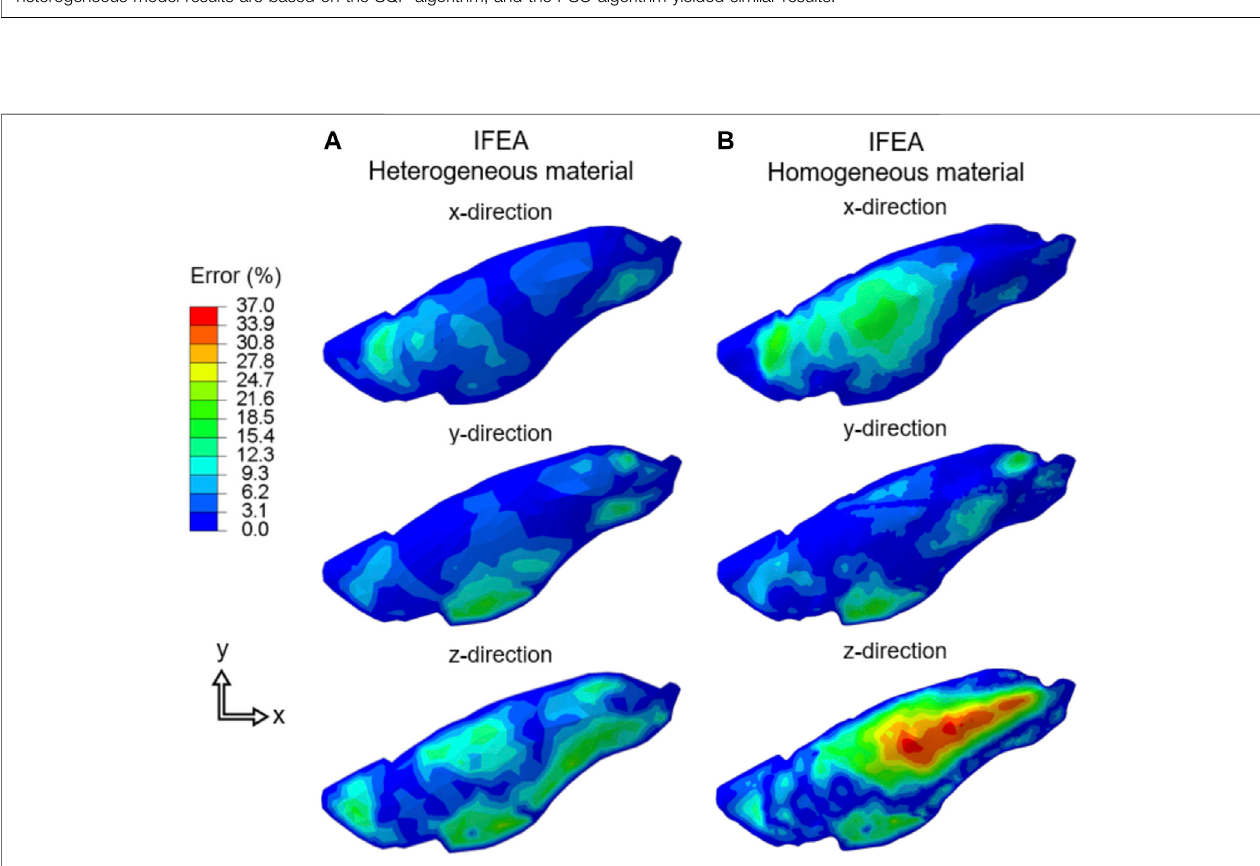
FIGURE 6 | The displacement error (Cartesian components) of the IFEA predictions assuming (A) heterogeneous and (B) homogeneous material models. The errors for the heterogenous model were consistently smaller. SQP algorithm shown for the heterogeneous model error and the PSO algorithm yielded similar results.